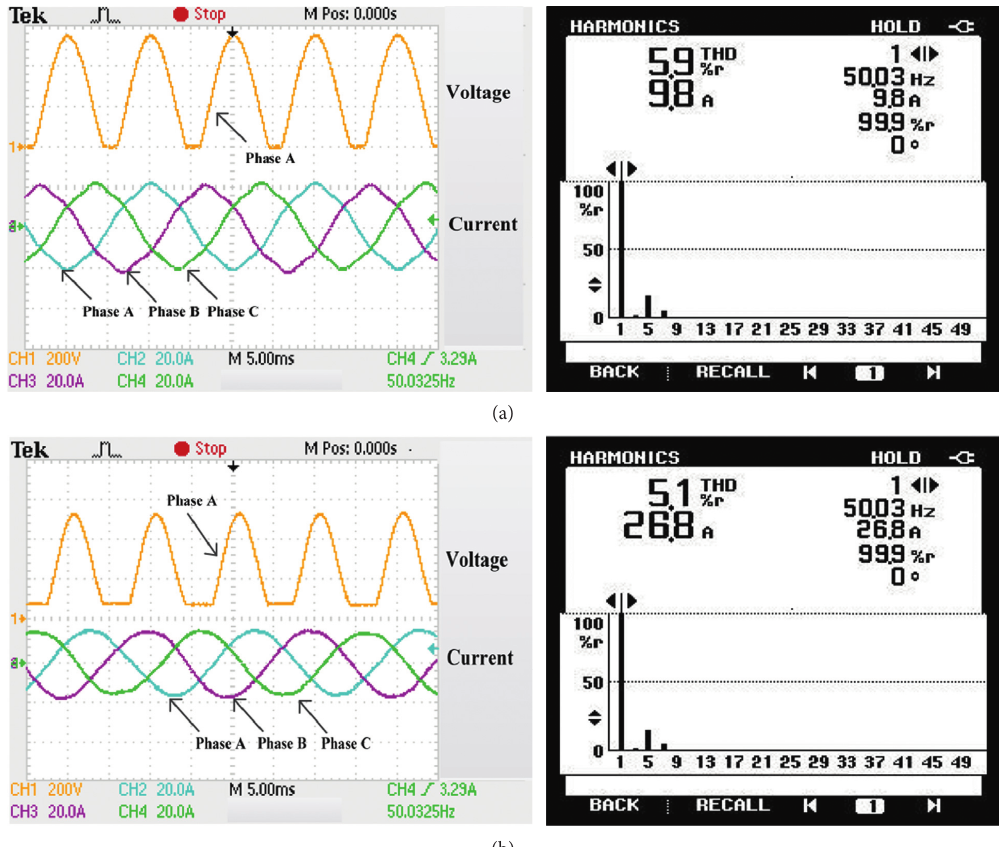
Figure 14: Optimal regulation of capacitance voltage peak and total harmonic distortion: (a) point A before optimization; (b) point A after